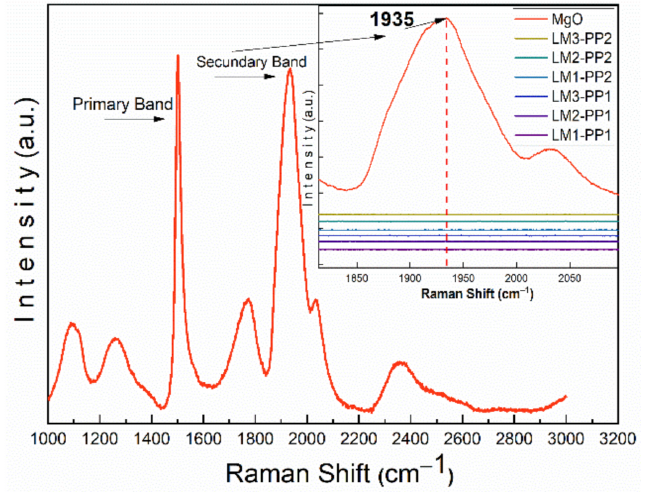
Figure 8. Comparative Raman spectra of MgO and leached